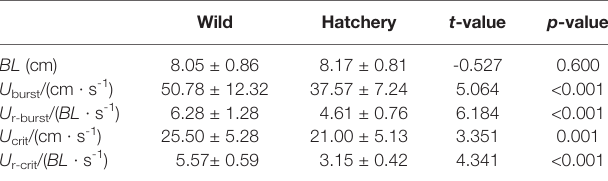
TABLE 2 | Comparison of the swimming ability between the wild and hatchery- reared marbled rock fi sh. Wild Hatchery